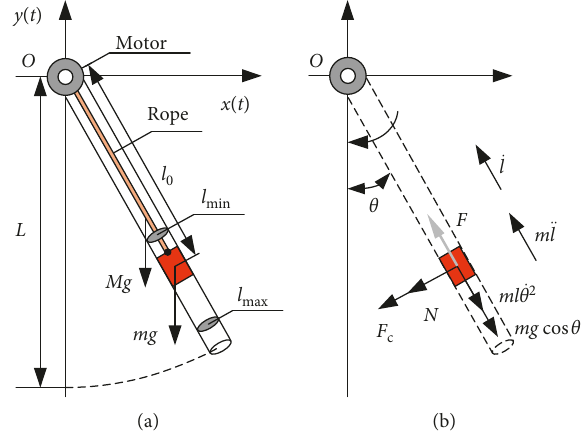
Figure 1: The pendulum with a moving mass. (a) Coordinate system; (b) forces involved.